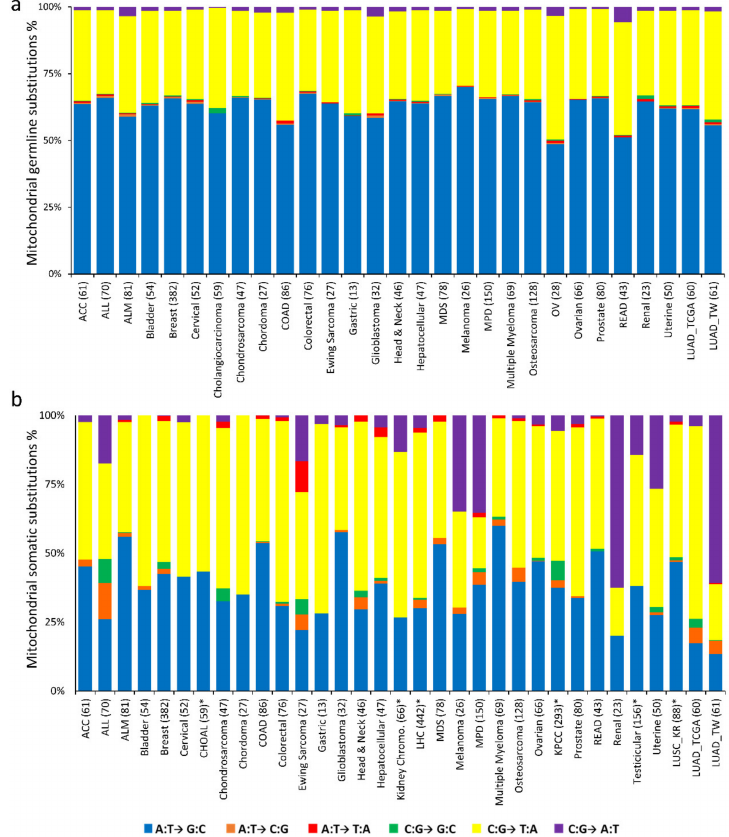
Figure 3. Nucleotide substitution profiles of mitochondrial mutations. ( a ) Nucleotide substitution profiles of germline mitochondrial mutations among di ff erent cancers. ( b ) Nucleotide substitution profiles of somatic mitochondrial mutations among di ff erent cancers. Cancer types marked with * provided the somatic mutation in the coding region only. Abbreviations: ACC: adenoid cystic carcinoma; ALL: acute lymphocytic leukemia; ALM: acute myeloid leukemia; CHOAL: cholangiocarcinoma; COAD: colon adenocarcinoma; Kidney Chromo.: kidney chromophobe; LHC: liver hepatocellular carcinoma; MDS: myelodysplastic syndromes; MPD: myeloproliferative disorders; OV: ovarian serous cystadenocarcinoma; KPCC: kidney renal papillary cell carcinoma; READ: rectum adenocarcinoma; LUAD_TCGA: lung adenocarcinoma TCGA; LUSC_KR: lung squamous cell carcinoma Korea; LUAD_TW: lung adenocarcinoma